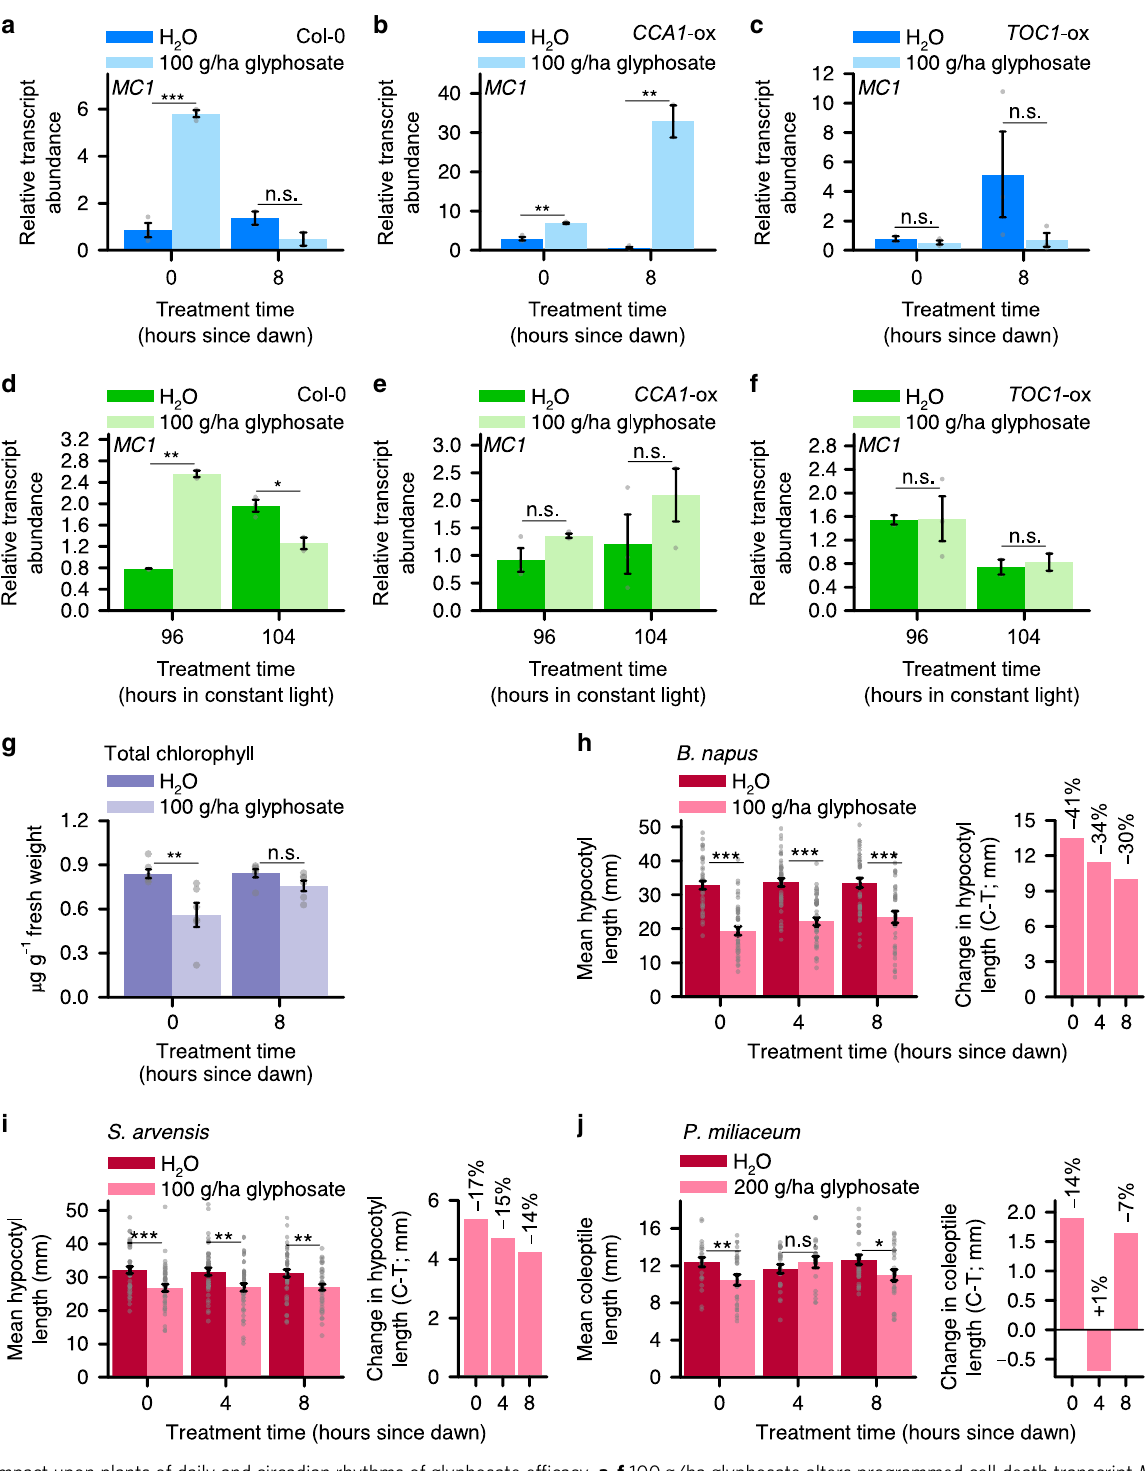
Fig. 4 Impact upon plants of daily and circadian rhythms of glyphosate ef fi cacy. a – f 100 g/ha glyphosate alters programmed cell death transcript MC1 in a time of day-dependent manner under both light-dark cycles ( a – c ) and constant light ( d – f ). Reference transcript was PP2AA3 . g 100 g/ha glyphosate alters total chlorophyll content depending on the time of day of application. h – j Diel changes in sensitivity of hypocotyl or coleoptile length to glyphosate in agriculturally relevant species. h, i Mean hypocotyl length of B. napus and S. arvensis and treated with 100 g/ha glyphosate and j mean coleoptile length of P. miliaceum treated with 200 g/ha glyphosate. Graphs show (left) hypocotyl/coleoptile length and (right) hypocotyl/coleoptile length change caused by glyphosate. A greater glyphosate concentration was required to alter coleoptile length in P. miliaceum (200 g/ha) compared with hypocoyl length in the dicots (100 g/ha), possibly because monocots and dicots have differing auxin responses 80 . Signi fi cance determined by two-way ANOVA and t -test comparisons between control and treatment at each timepoint. n.s. = not statistically signi fi cant, * P ≤ 0.05, ** P ≤ 0.01, *** P ≤ 0.001. Data are mean± s.e.m.; n = 2 – 3 (transcript analysis), n = 20 – 45 (data from multiple experiments, hypocotyl measurements). Source data are provided in the Source Data fi